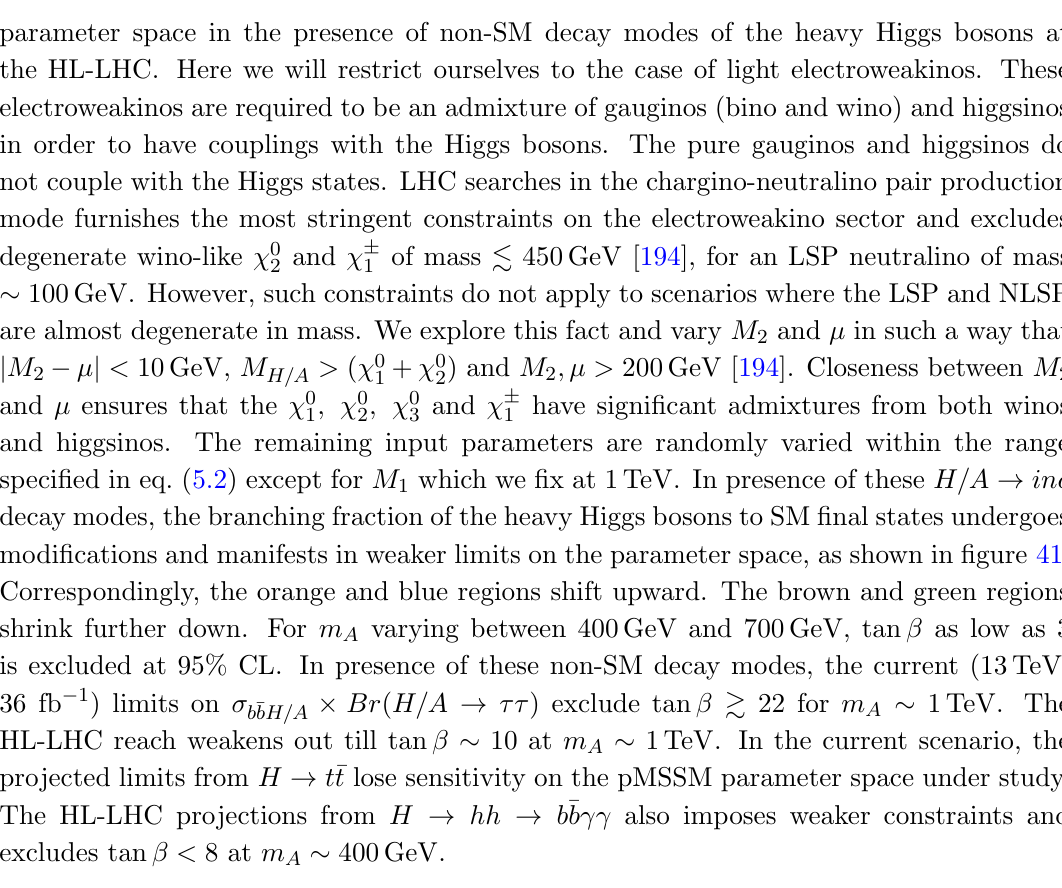
Figure 41 . Same as the left panel of (cid:12)gure 40 but for and M 2 ; (cid:22) > 200